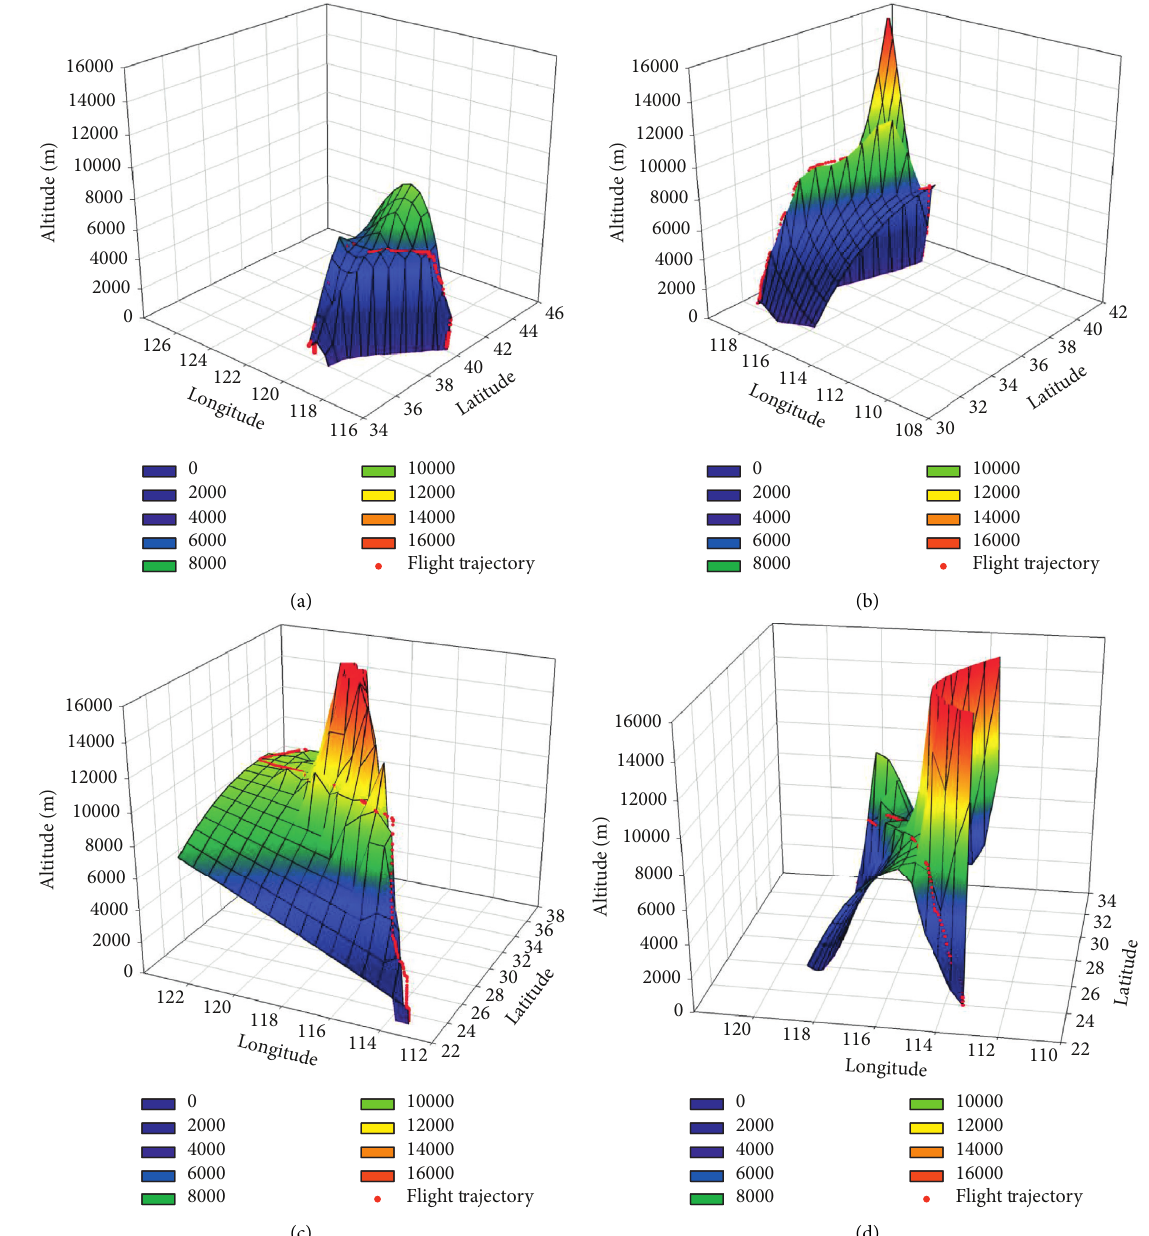
Figure 6: The flight profile for calculating the aircraft A320 in the hub-and-spoke network flight operation situation of A320 in the hub-and- spoke network. (a) Between Beijing and Qingdao. (b) Between Beijing and Nanjing. (c) Between Qingdao and Guangzhou. (d) Between Guangzhou and Nanjing. Table 6: Hub-and-spoke network pollutant emissions and fuel consumption. Pollutant emissions and fuel consumption Climbing and descending stages